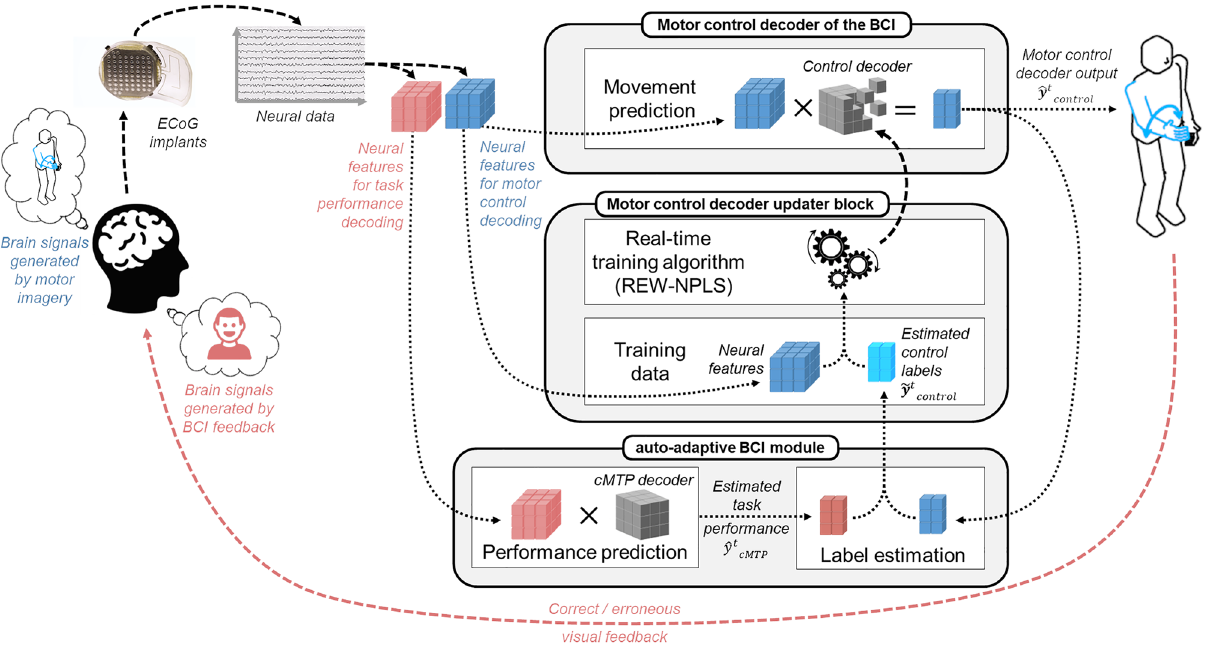
Figure 1. Diagram of the aaBCI framework. In addition to the control decoder block and the updater block common to most BCIs, the aaBCI features an auto-adaptive BCI module. The aaBCI module is responsible for the detection of neural correlates of continuous in time motor task performance (cMTP), as well as the estimation of labels for the control decoder ( (cid:31) y t control ) based on the output of the cMTP decoder ( (cid:31) y t cMTP ) and the output of the control decoder ( (cid:31) y t control